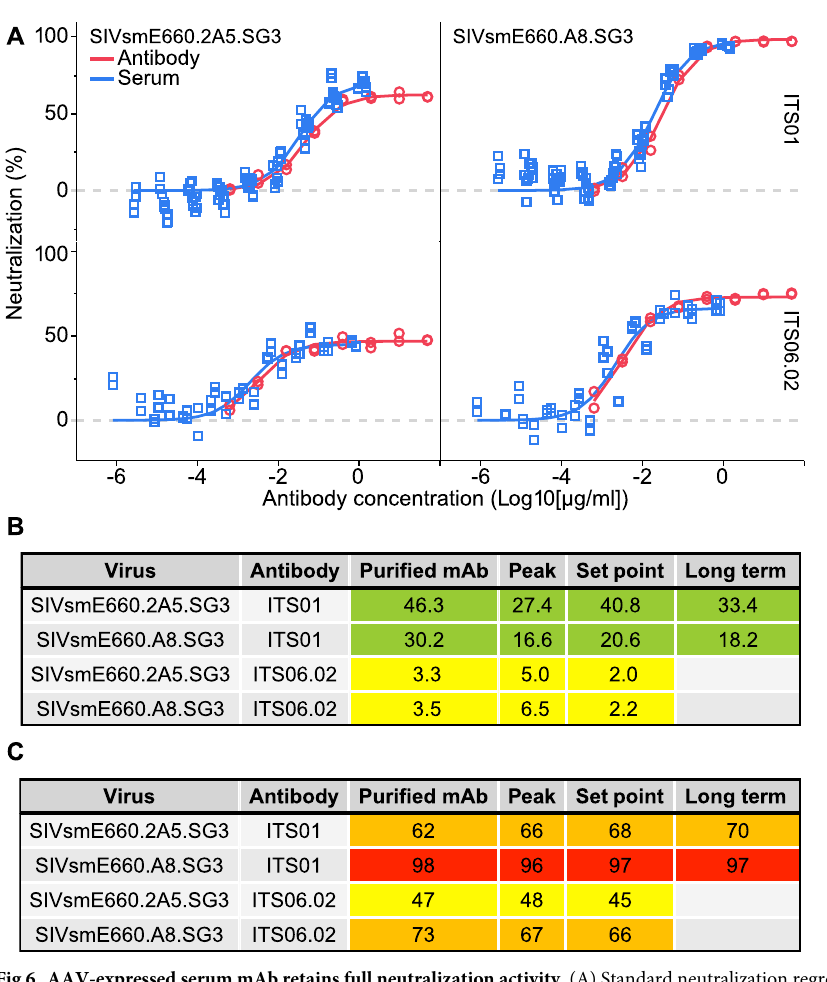
Fig 6. AAV-expressed serum mAb retains full neutralization activity. (A) Standard neutralization regression analyses are shown for ITS01 (upper) and ITS06.02 (lower) from purified mAb (red, open circles) or sera from AAV injected rhesus macaques (blue, open squares) (n = 6). Neutralization of SIVsmE660 clones 2A5 (left) and A8 (right) for mAbs and sera (ITS01, week 24; ITS06.02, weeks 5–8) are overlaid. (B) EC 50 (ng/ml) and (C) maximum neutralization (%) are listed for ITS01 and ITS06.02 purified or from transduced NHP sera. Antibodies in serum are derived from AAV injected animals at peak (week 4), set point (weeks 5–8) or long term (week 24) post AAV. EC 50 are displayed in ng/ml with the following color coding: 10–90 Light Green; 1–9 Yellow. Maximum neutralization values are displayed as percent with the following color coding: 20–49.9% Yellow; 50–74.9% Light Orange; 75–94.9% Orange; 95–100%